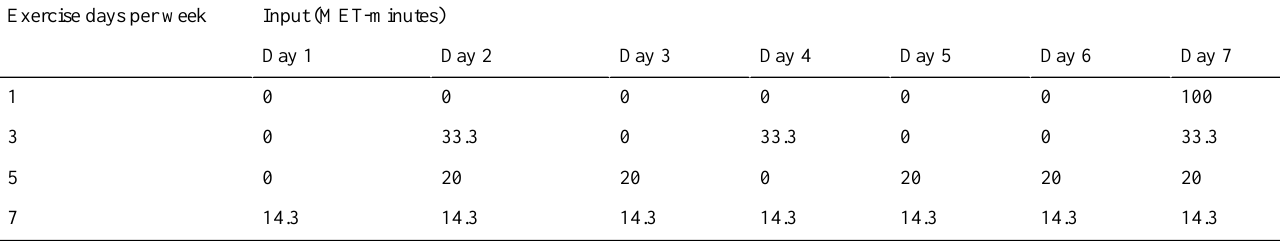
Table 1. Input distribution of ideal and periodic physical activity in a week.